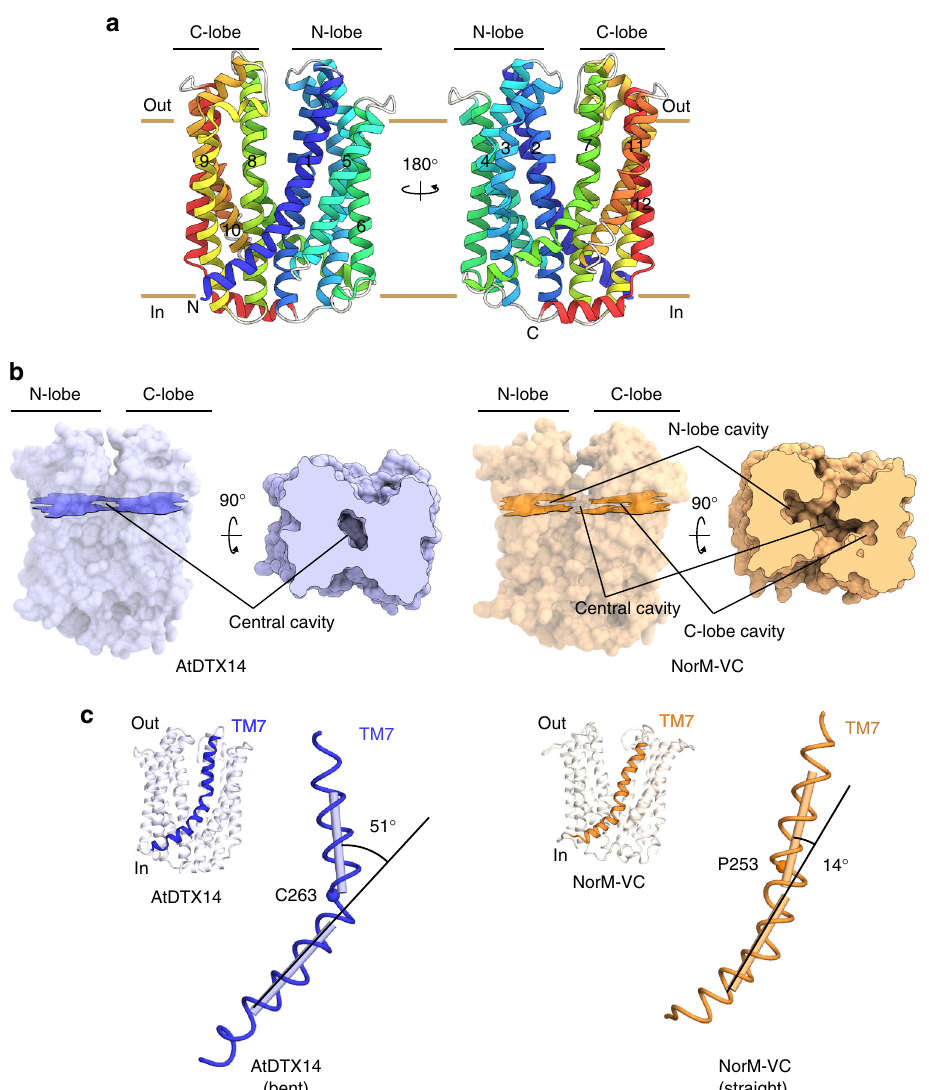
Fig. 2 Overall structure of AtDTX14. a Cartoon representations of the crystal structure of AtDTX14, viewed parallel to the membrane. The structures are colored from blue to red from the N terminus to the C terminus. b Surface representations and cross-sections of AtDTX14 and NorM-VC (PDB ID: 3MKT). The cross-sections are viewed perpendicular to the membrane, for comparison of their cavities. c Comparison of the helix axis angles of TM7 between AtDTX14 (blue) and NorM-VC (orange). All molecular graphics were created with the program CueMol